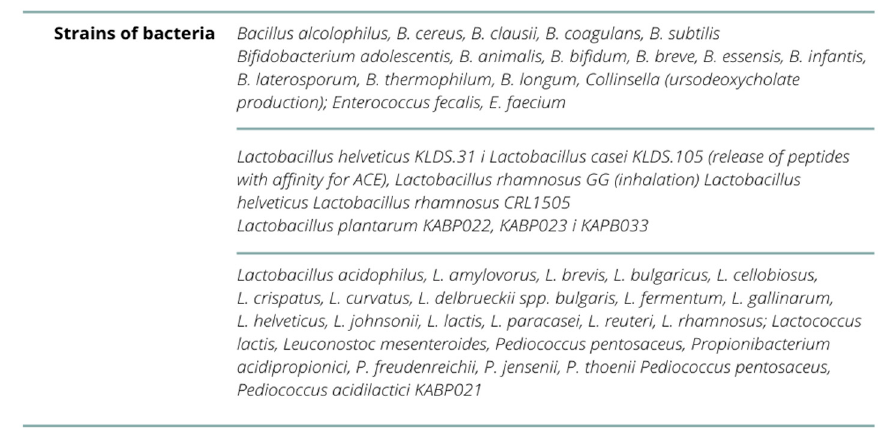
Figure 6. Strain cultures with widely proven, individualized and strongly confirmed therapeutic